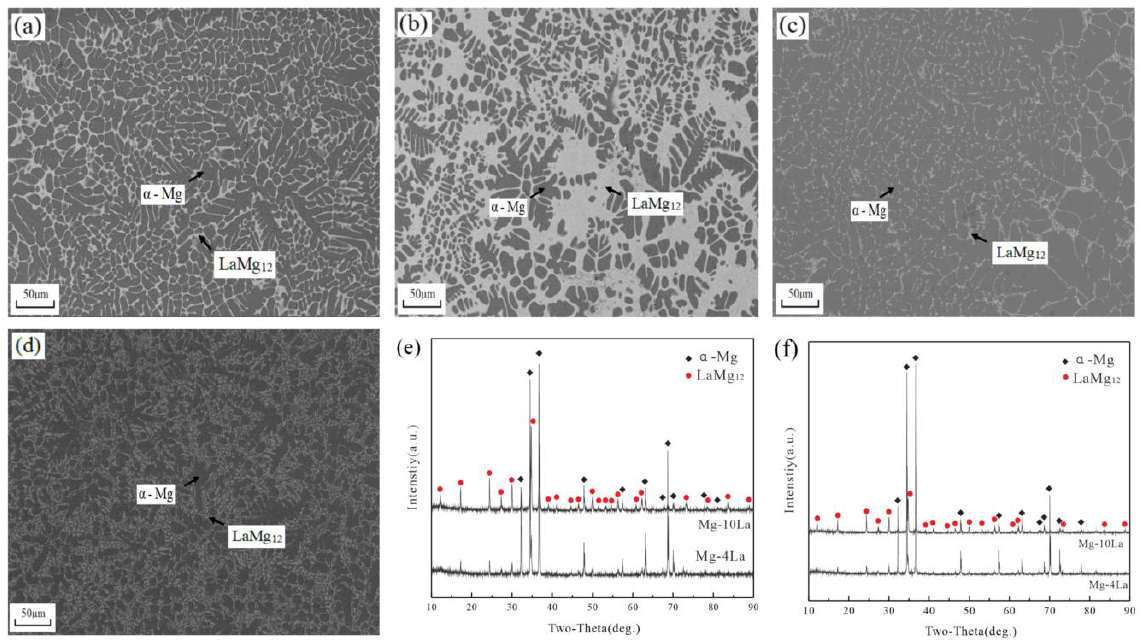
Figure 2. BSE micrographs of ( a ) the as-cast Mg-4La alloy, ( b ) the as-cast Mg-10La alloy, ( c ) the annealed Mg-4La alloy, and ( d ) the annealed Mg-10La alloy; and XRD diffraction patterns of ( e ) the as-cast Mg-4La and Mg-10La alloys, and ( f ) the annealed Mg-4La and Mg-10La alloys.